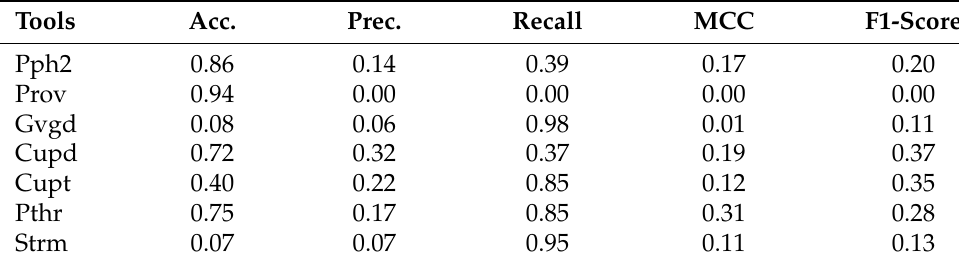
Table A2. The outer consistency results for the BRCA1-HDR dataset.